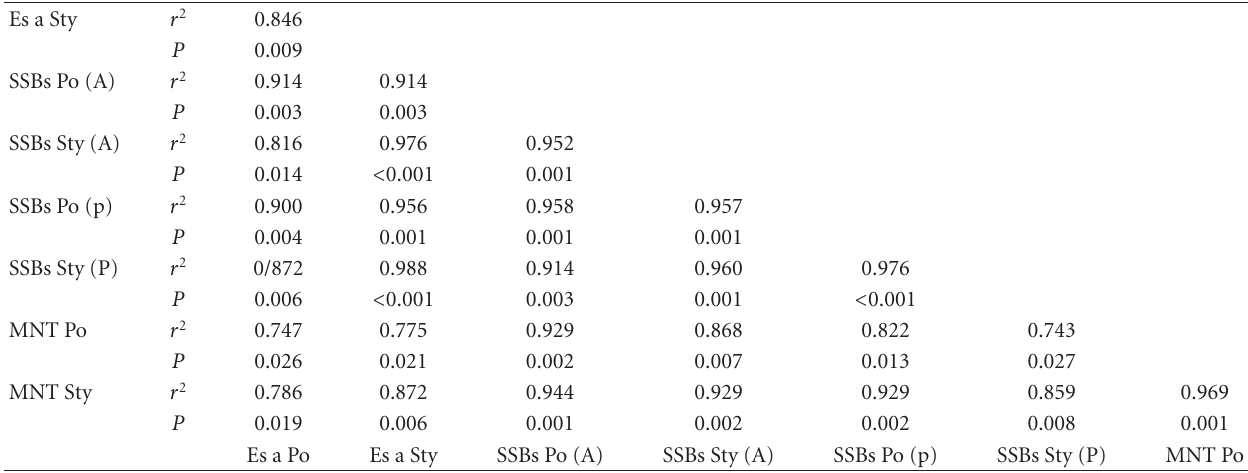
Table 2: Results of the regression between the cytological tests of samples from the natural reefs. Samples were collected from Stylophora pistillata (Sty) and Pocillopora damicornis (Po). In each square, the top figure is r 2 and the bottom is the P value. MNT: micronucleus test, SSBs: − log single strand breakage (A) with a acridine orange and (P) with PicoGreen. Es a: esterase activity.